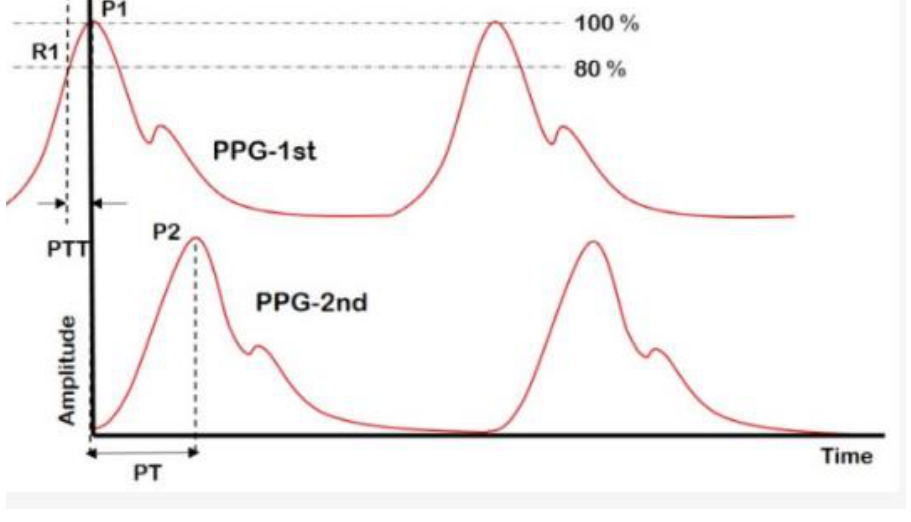
Figure 5. Example of pulse transit time [167] CC by 4.0.